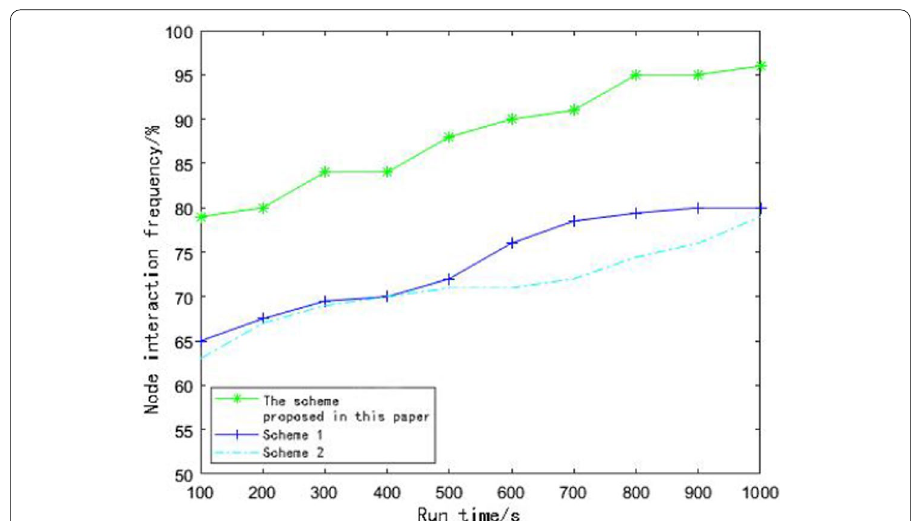
Fig. 6 The adaptability in low‑frequency‑aware network of dynamic